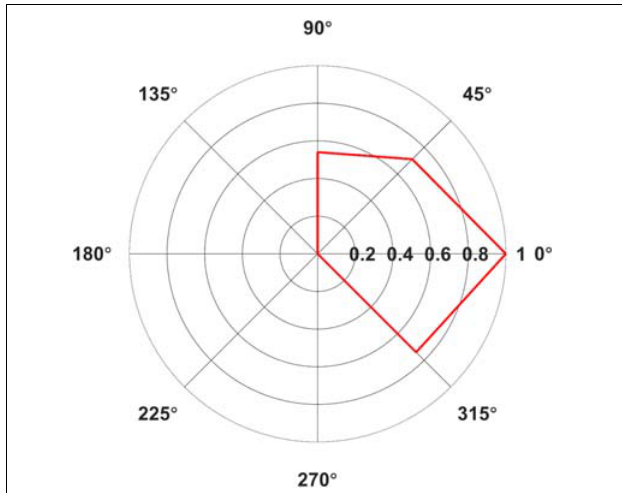
FIGURE 2 | Polar plot of average Area Under the Curve (AUC) elicited from contralateral (A) Orbicularis Oris (OO) in mV · ms for Middle Latency MEPs only. Only average values with > 5 contributing subjects are included. Values normalized relative to the largest value, set to